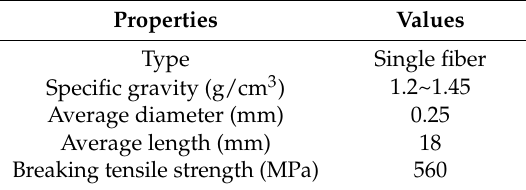
Figure 1. Photograph of the short sisal fiber. Table 3. Physical and mechanical properties of the sisal fiber (from Hejazi et al. 2012 [1]).